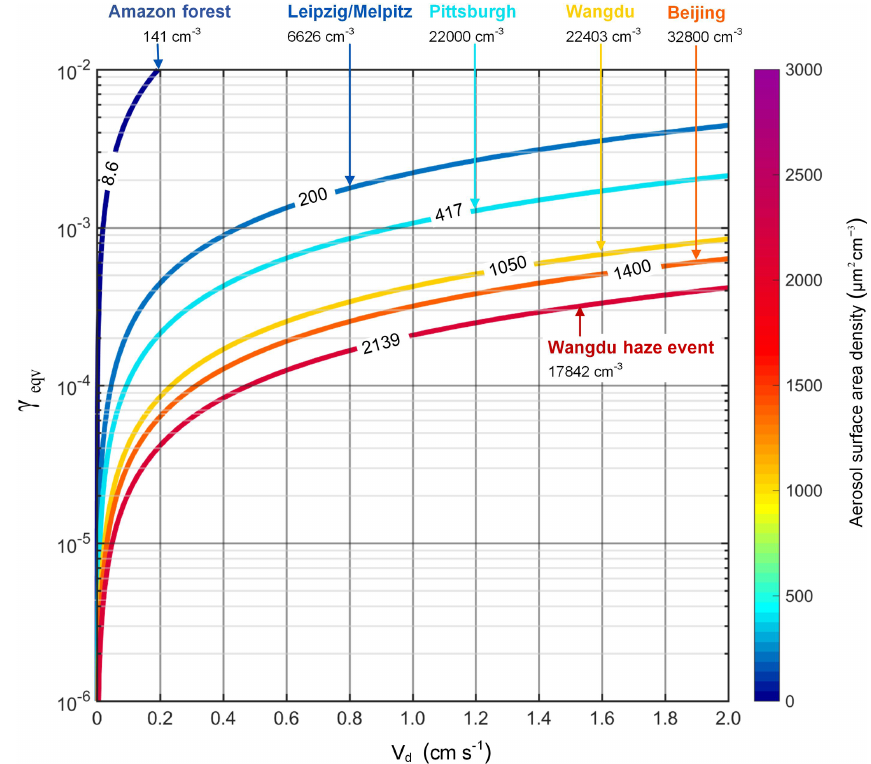
Figure 2. Relation between γ eqv and V d for a mixing height of 300m and aerosol surface area densities ( A ) observed at different locations and under different conditions: Amazon forest (Pöschl et al., 2010), Leipzig/Melpitz (Ma et al., 2014; Ma and Birmili, 2015), Pittsburgh (Stanier et al., 2004), Wangdu with and without haze event (Wu et al., 2017) and Beijing (Wu et al., 2008). For each city/condition, the line is labeled with the corresponding aerosol surface area density. Aerosol particle number concentrations are also provided for